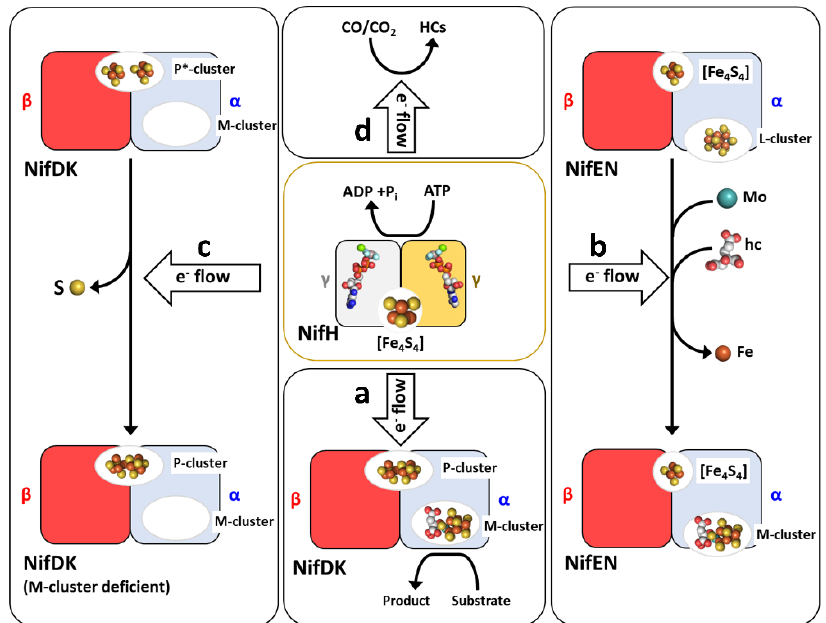
Figure 2. The many roles of the Fe protein (NifH) in substrate reduction and metallocluster assembly. Shown are the functions of NifH as ( a ) an electron donor for its catalytic partner, MoFe protein (NifDK), in nitrogenase catalysis; ( b ) a Mo/homocitrate (hc) insertase for the maturation of an L-cluster ([Fe 8 S 9 C]) into a fully assembled M-cluster ([( R -homocitrate)MoFe 7 S 9 C]) on a biosynthetic scaffold, NifEN; ( c ) a reductase for the reductive coupling of a P*-cluster (an [Fe 4 S 4 ]-like cluster pair) into a P-cluster ([Fe 8 S 7 ]); and ( d ) an independent reductase for the reduction of CO and/or CO 2 into hydrocarbons (HCs). All functions of Fe protein require an electron source ( a – d ), with its functions in nitrogenase catalysis ( a ) and biosynthesis ( b , c ) also rely on ATP hydrolysis. In comparison, the function of Fe protein as a reductase on its own requires an electron source, but it can be accomplished with or without MgATP ( d ). For the purpose of simplicity, only one αβ -dimer is shown for the tetrameric NifDK ( a ), its cofactor-deficient variant ( c ), and NifEN ( b ), with each αβ -dimer interacting with one NifH dimer. The subunits, clusters, and MgADP•AlF 4 ‒ are presented and colored as those in Figure 1.